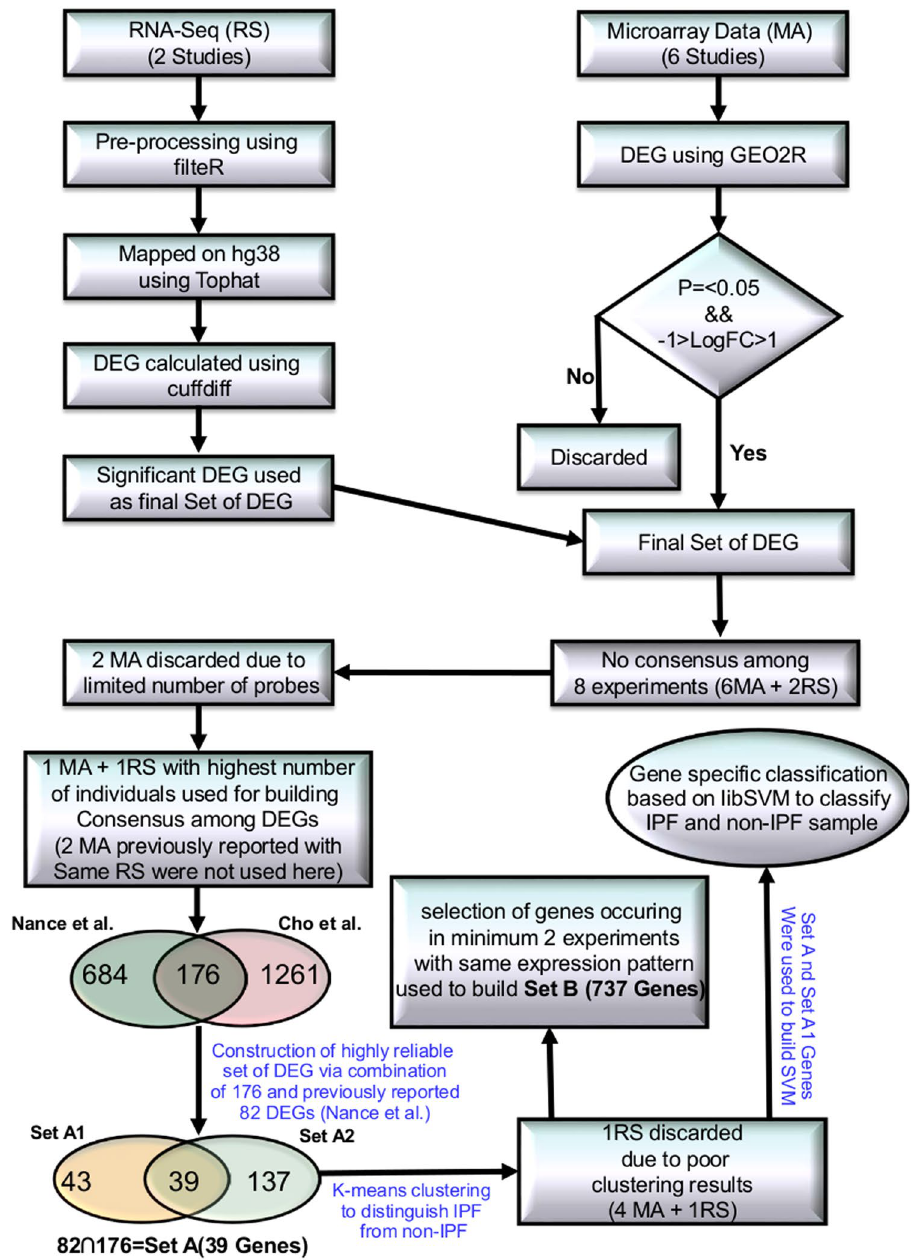
Figure 3. Protocol showing various steps in high-throughput data processing. Two MA studies were discarded due to less number of probes. Initially, Set A2 was constructed using one MA (GSE21411) 9 and one RNA-seq (SRP033095) 13 study. Set A was developed from overlap of Set A1 and Set A2. To construct Set B, DEGs were chosen so that they occurred in least two different high throughput studies. A SVM based classification model was generated for using Set A to distinguish IPF sample from non IPF